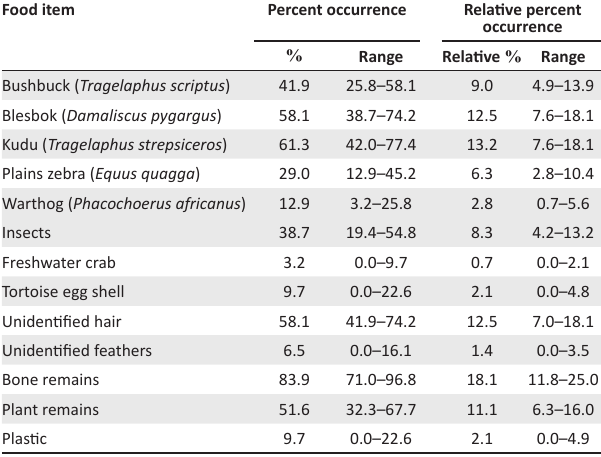
percentage occurrence and relative percentage